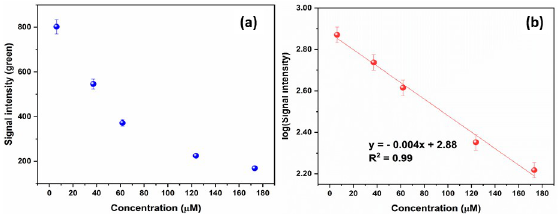
Fig 6. (a) Signal intensity recorded from Arduino device based on home-made reader vs SP concentration; (b) Relationship between log(S) and spermine